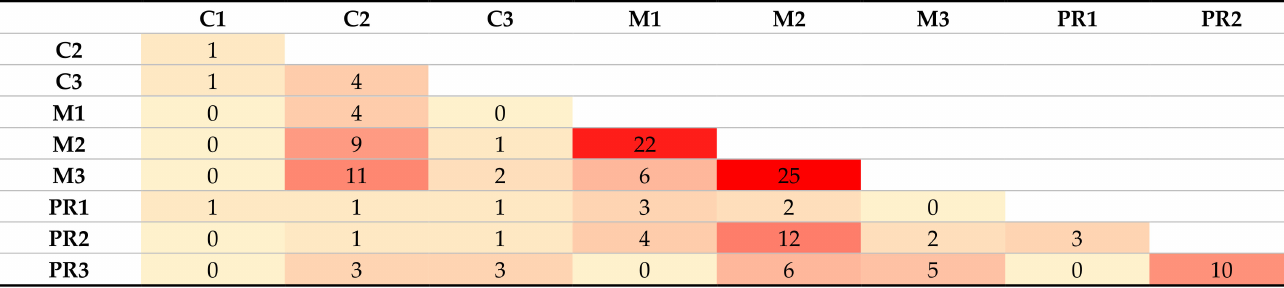
Figure 7. Heat-map representation of aggregated code interactions within NREAP policies for Denmark, Ireland, and the UK, highlighting interactions between two codes within the same